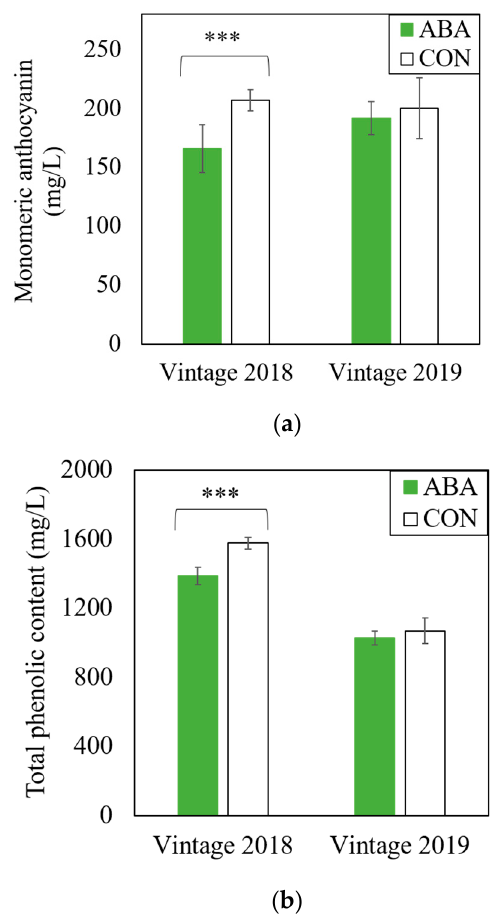
Figure 1. Effects of exogenous abscisic acid application (ABA) to the fruit zone and no abscisic acid control (CON) on levels of monomeric anthocyanin ( a ) and total phenolic content ( b ) in wines pro- duced from GRBV-positive Pinot noir vines. Two-sample t -test was conducted for p -value calculation between ABA and CON in each year (***: p <